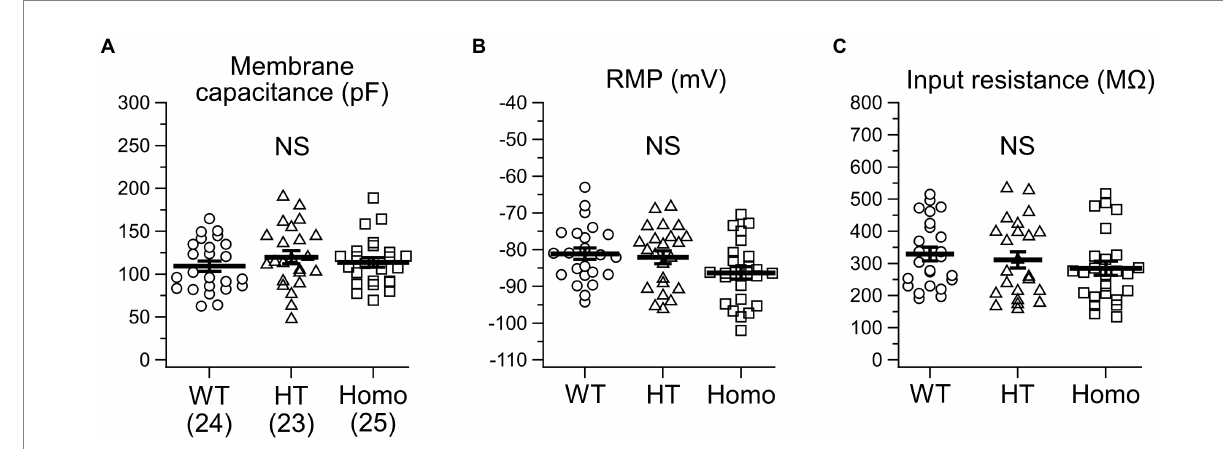
FIGURE 1 Passive membrane properties of somatosensory layer II/III pyramidal neurons in heterozygous (HT) and homozygous (Homo) TauT KO mice and wildtype (WT) littermates. (A) Comparison of cellular membrane capacitance around the soma. The numbers in brackets indicate the numbers of neurons analyzed. These are the same in all the figures except Figure 6 in this study. WT: 109.4 ± 6.1 pF, HT: 119.8 ± 7.6 pF, Homo: 113.9 ± 5.6 pF, p = 0.535 by ANOVA. (B) RMP. WT: − 81.1 ± 1.6 mV, HT: − 82.1 ± 1.8 mV, Homo: − 86.3 ± 1.7 mV, p = 0.067 by ANOVA. (C) Input resistance. WT: 329.3 ± 21.2 M Ω , HT: 311.2 ± 25.1 M Ω , Homo: 284.8 ± 22.1 M Ω , p = 0.379 by ANOVA. NS, not significant. (A–C) Symbols indicate the values in individual neurons, and thick horizontal bars with error bars indicate means ±